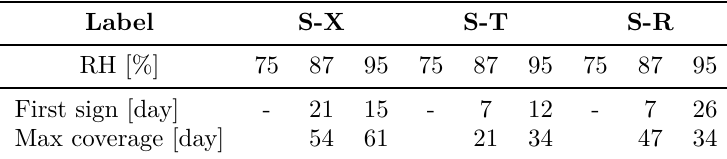
Table 2. Time in days required for the first signs of mold growth and the maximum coverage of spruce